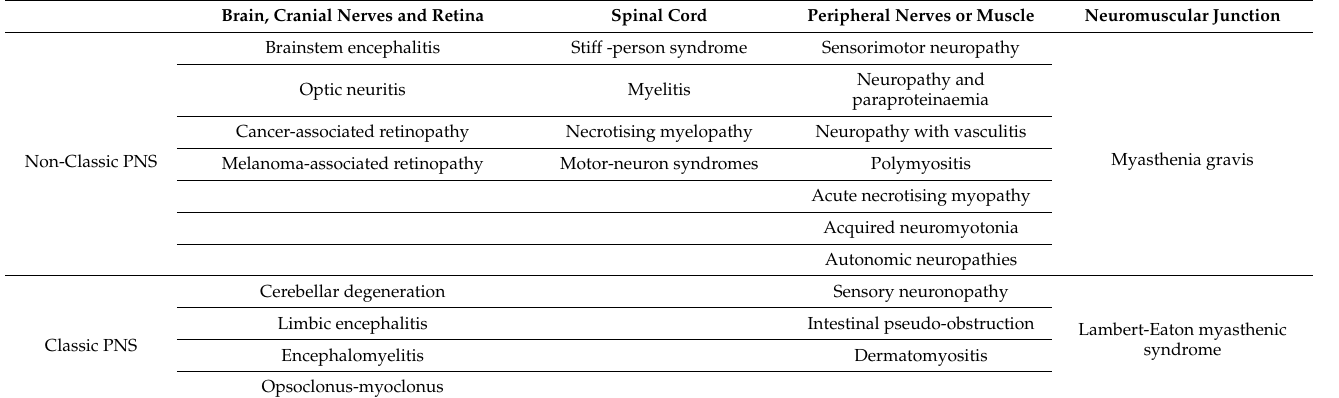
Table 1. Paraneoplastic syndromes of the nervous system classified by location. Adapted from Dalmau J, Rosenfeld MR. Paraneoplastic syndromes of the CNS. Lancet Neurol . 2008; 7(4): 327–340. [6]. Brain, Cranial Nerves and